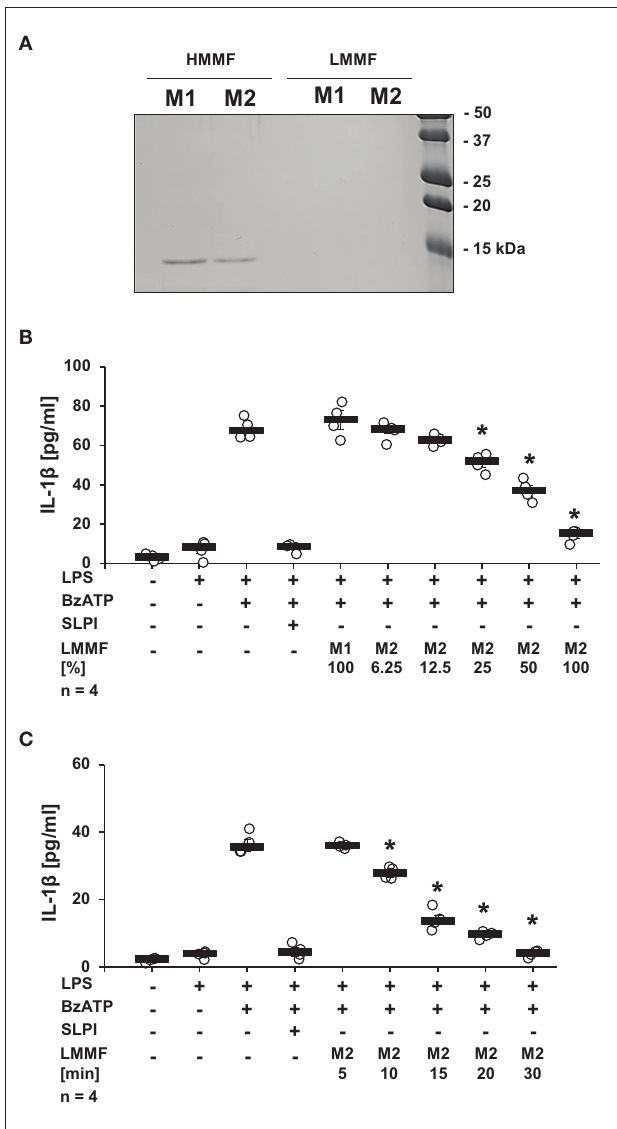
FIGURE 11 | SLPI induces the release of a bioactive factor. Human monocytic U937 cells were primed with LPS (1 µ g/ml) for 5h and further cultured for additional 30min in the absence (M1) and presence (M2) of SLPI (10 µ g/ml). Conditioned media were collected and separated by ultrafiltration (cut-off 3 kDa) into high (HMMF) and low molecular mass fractions (LMMF). Conditioned medium M1 was supplemented with SLPI shortly before ultrafiltration. (A) HMMF and LMMF of M1 and M2 were separated by SDS-PAGE (15% acrylamide) along with marker proteins and stained with Coomassie Brilliant Blue. A band with an apparent molecular mass of about 15 kDa corresponding to SLPI was only detected in the HMMF (B) LPS-primed U937 cells were stimulated with 2 ′ (3 ′ )-O-(4-benzoylbenzoyl)adenosine 5 ′ -triphosphate triethylammonium salt (BzATP; 100mM) for 30min in the presence of different concentrations of the LMMF of M2. LMMF of M1 was applied as a control. LMMF of M2 dose-dependently inhibited the BzATP-induced IL-1 β release. (C) LMMF of M2 collected at different time-points after SLPI application was applied to U937 cells primed with LPS and stimulated with BzATP for 30min. The IL-1 β release was measured by ELISA. n = 4, * p ≤ 0.05 significantly different compared to U937 cells stimulated with LPS and BzATP. Experimental groups were compared by Kruskal-Wallis test followed by Mann-Whitney rank sum